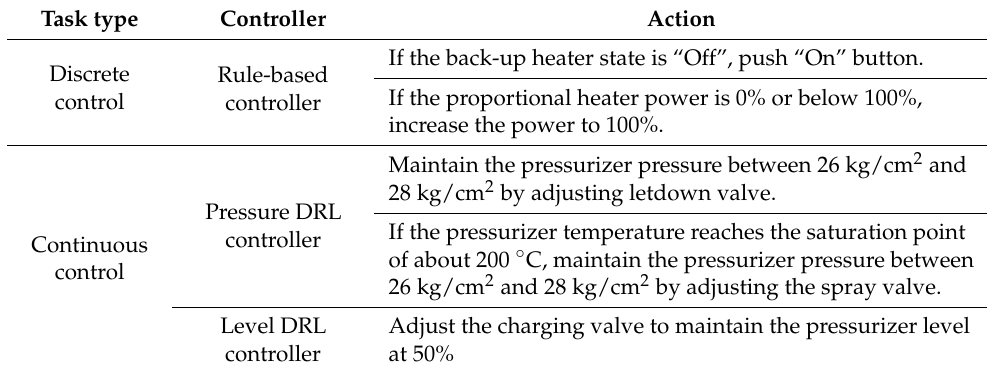
Table 4. Controller tasks for cold shutdown